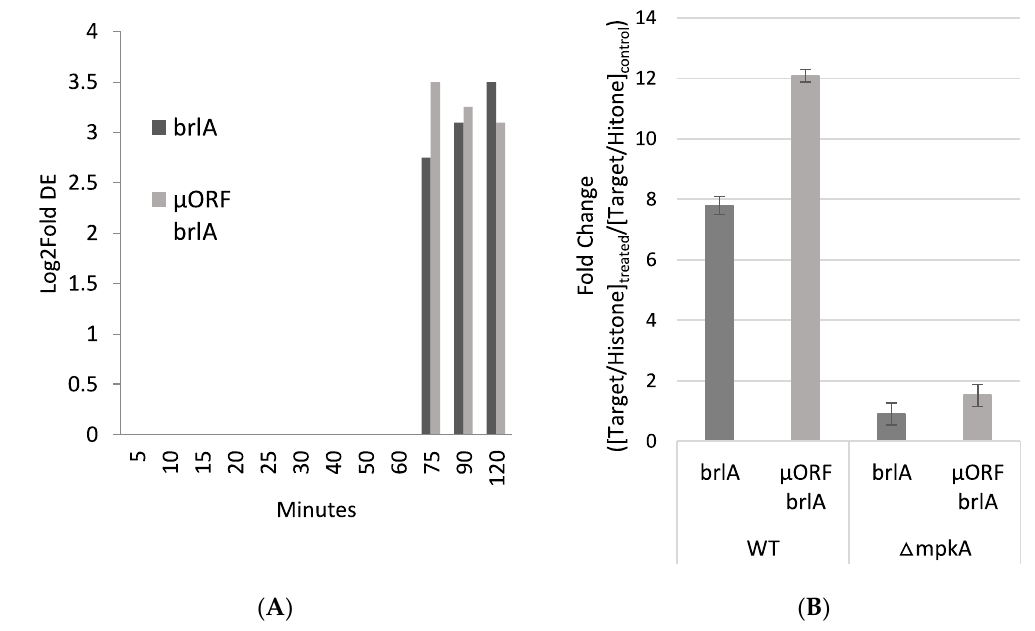
Figure 3. brlA Up-regulated in Wild Type but not Δ mpkA ( A ) RNA-Sequencing data showing brlA and brlA µORF up-regulated in wild type starting the adaptation phase. Three biological replicates. Significance DE = Log2Fold > 2.0. ( B ) qRT-PCR at the last time point, brlA and brlA µORF are up-regulated in wild type but not in Δ mpkA. Three biological replicates.